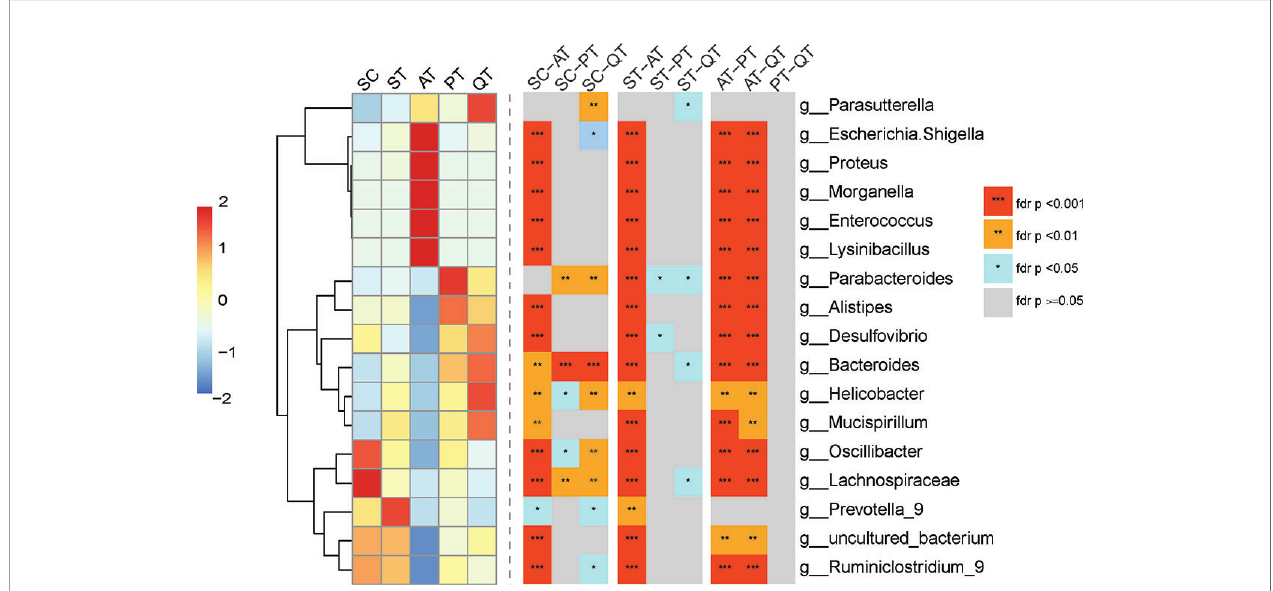
FIGURE 3 | Heatmap of top seven species abundance and compositional differences of cecum content from fi ve treated groups across the genus level. (Left) Abundance distribution of dominant 16 genera (Y-axis) across SC, ST, AT, PT, and QT groups (X-axis) were displayed, which were arranged along the x-axes based on hierarchical clustering. Red represents the genera with high abundance in the corresponding treated groups, while blue represents genera with low abundance. (Right) Heatmap depicting differentially abundant genera of any two group of fi ve treated groups. FDR values indicated by asterisks on the color lump of Figure (***FDR < 0.001, **FDR < 0.01, *FDR <